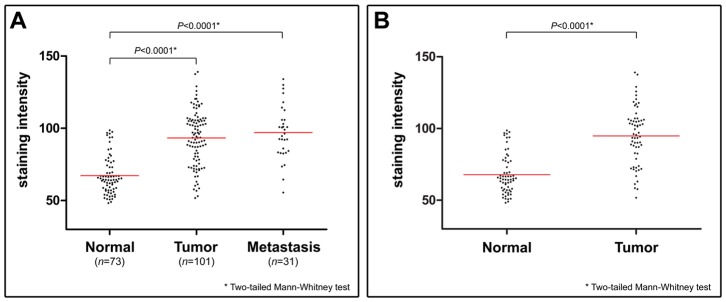
Differential expression of BLCAP in tumor samples.The DCTB 123 patient set, including normal, tumor and lymph node metastasis samples (A), or a subset of matched 62 normal and tumor samples (B) were analyzed by quantitative IHC. Mean intensity scores for each group are indicated by red lines.